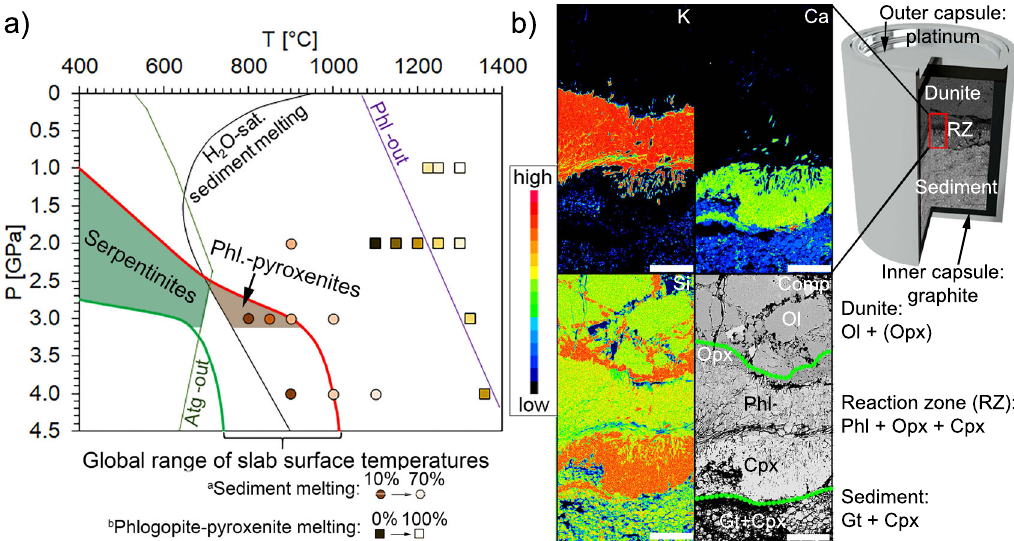
Fig. 1 Sediment melting experiments compared to global slab surface temperatures (a) and element maps of sediment-peridotite reaction zone products (b). a The global range of slab surface temperatures (area between green and red lines, D80 model of Syracuse et al. 9 ) overlaps with the H 2 O saturated sediment melting curve 36 within the fore-arc mantle, in front of the slab-mantle coupling region. Subducted sediments cross the solidus of H 2 O- saturated sediment melting at ~2.5 – 3.2 GPa and ~675 – 950 °C to react with mantle peridotites, producing phlogopite-pyroxenites (grey shaded area). Reaction experiments con fi rm sediment melting at fore-arc mantle conditions (circles) 11,12 and the stability of phlogopite-pyroxenites at T < ~1100 °C (squares) 45,46 . At lower pressure and temperatures, serpentinites are present within the stability fi eld of antigorite (green shaded area). Both the serpentinite and phlogopite-pyroxenite fi elds are con fi ned to >3.2 GPa, which translates to ~100 km and should be regarded as the maximum thickness of the fore-arc lithosphere. b Reaction experiments demonstrate that the interaction of sediment melt with depleted peridotite (dunite) produces phlogopite- pyroxenites and enriches the former peridotite in K, Ca and Si. The location of the reaction zone is given on a rendered image of the capsule, which is about 4 mm in diameter. Scale bar corresponds to 100 µ m. Atg Antigorite, Phl